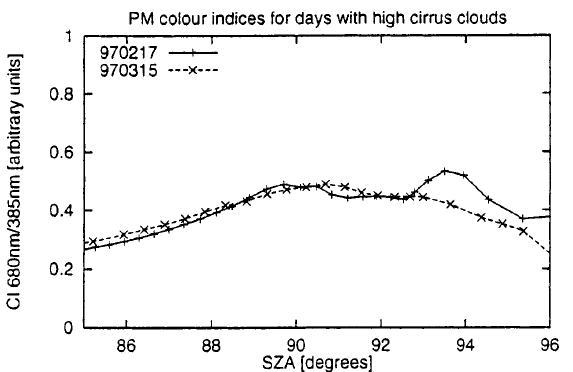
Fig. 2. Colour index development during days with high cirrus clouds